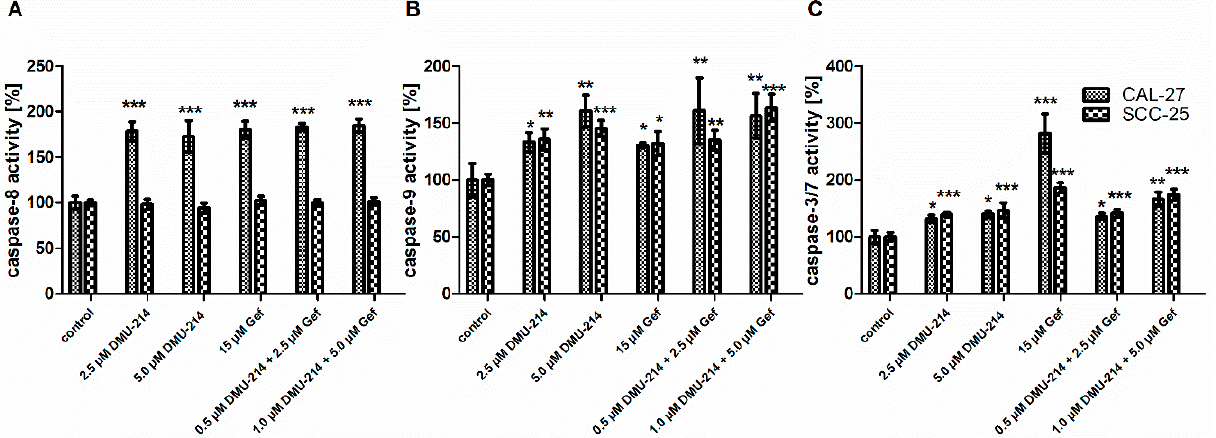
Figure 3. Effect of DMU-214, Gef, and the combination of DMU-214 and Gef on caspases activity in CAL-27 and SCC-25 cell lines compared to the vehicle-treated control. The casp-8 ( A ), -9 ( B ) and -3/7 ( C ) activities were determined by Caspase- Glo ® -8, -9, -3/7 assay. Results of three independent replicates are presented as mean ± SD. *** p < 0.001, ** p < 0.01, * p < 0.05 indicate a significant difference from the control.